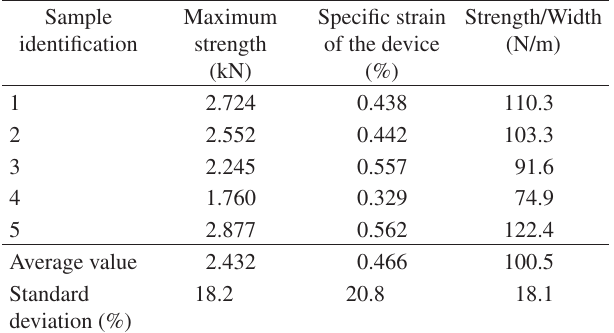
Table 6. Shear test results – non-oil impregnated Eucalyptus citriodora